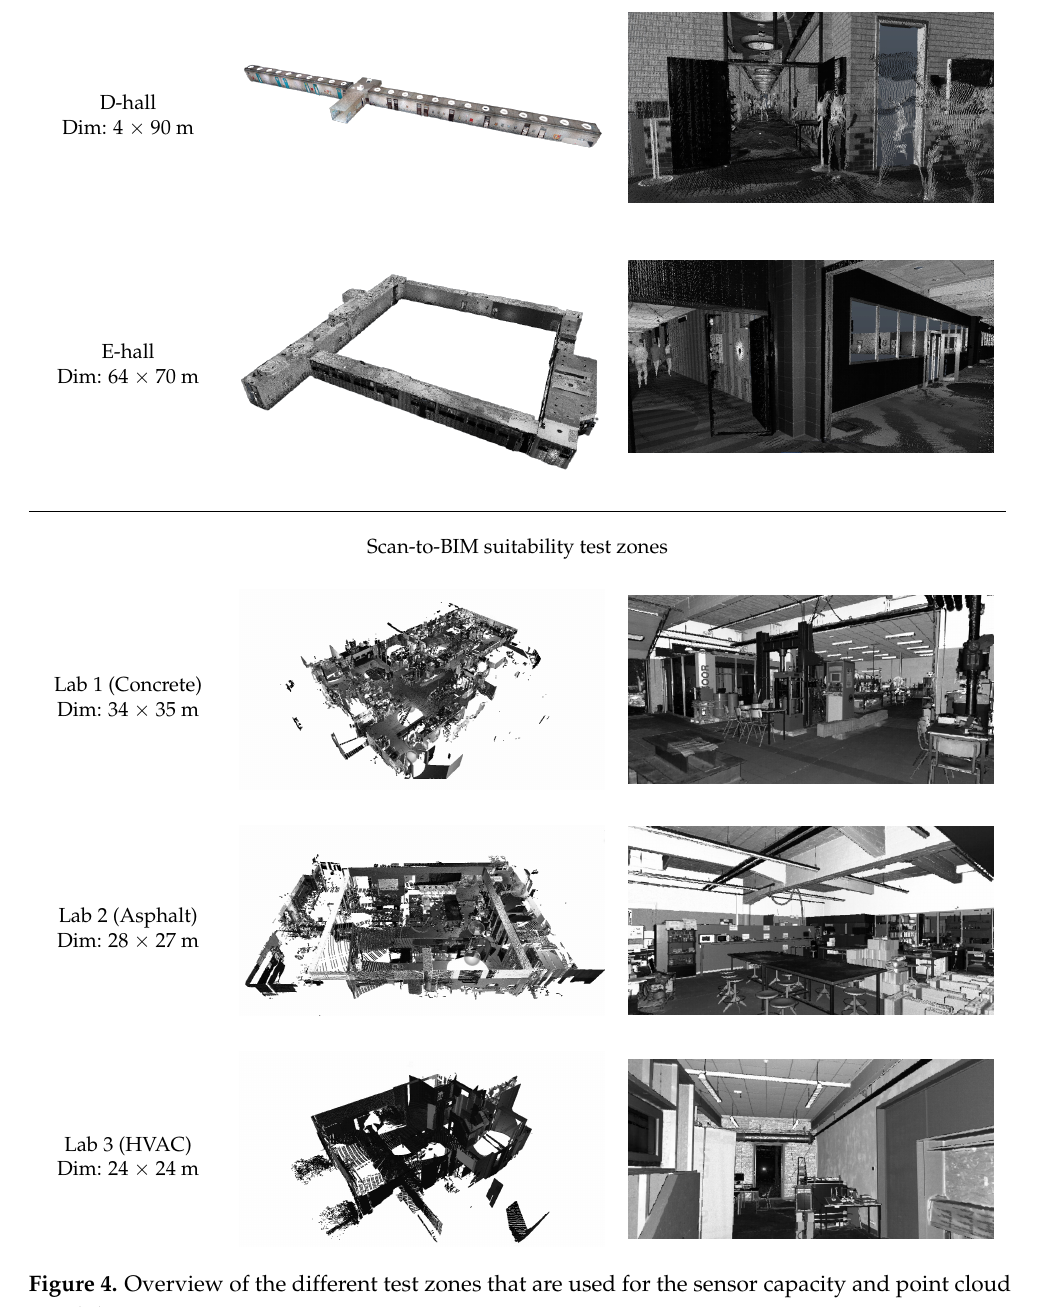
Figure 4. Overview of the different test zones that are used for the sensor capacity and point cloud suitability